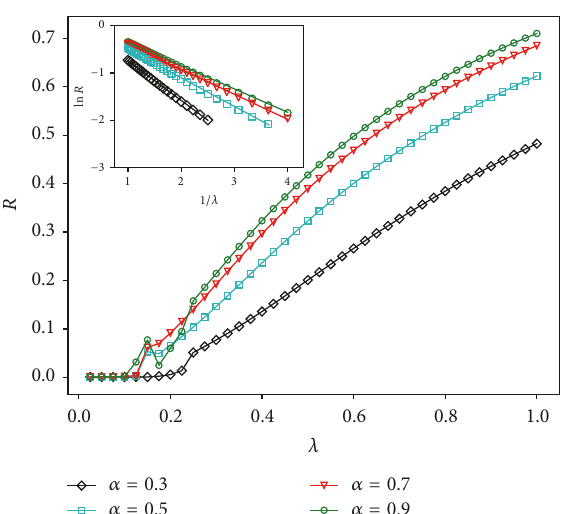
Figure 3: Final rumor size 𝑅 as a function of spreading rate 𝜆 varying over different parameter 𝛼 . Insets show the exponential correlation of 𝑅 and 1/𝜆 when 𝛼 is greater than threshold 𝛼 𝑐 .